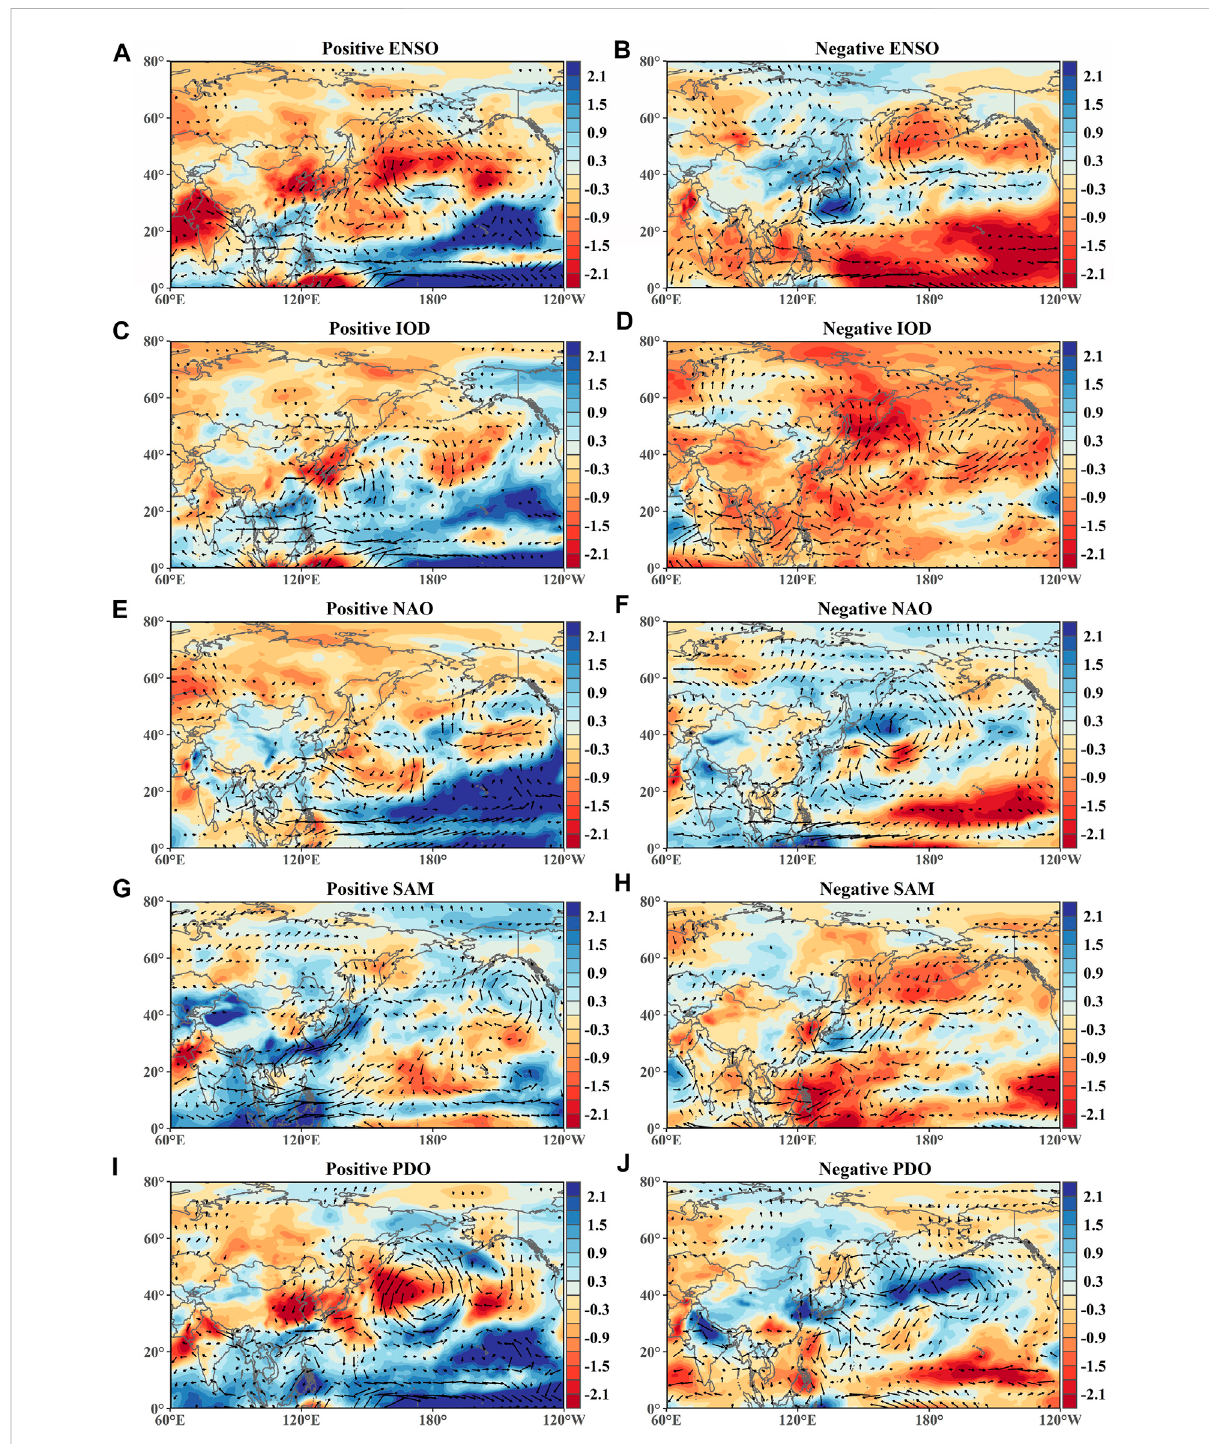
FIGURE 8 Composite patterns of precipitable water (shadows) and water vapor fl ux (arrows) anomalies in the days (Julian days 146 – 244) that extreme precipitation frequently occurred in. The anomalies are obtained from the most fi ve positive and negative phases of ENSO (A – B) , IOD (C – D) , NAO (E – F) , SAM (G – H) , and PDO (I – J) ,